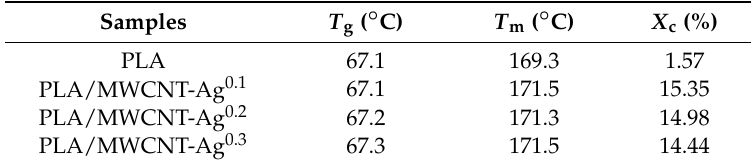
Table 2. DSC values of PLA and PLA/MWCNT-Ag nanocomposites.